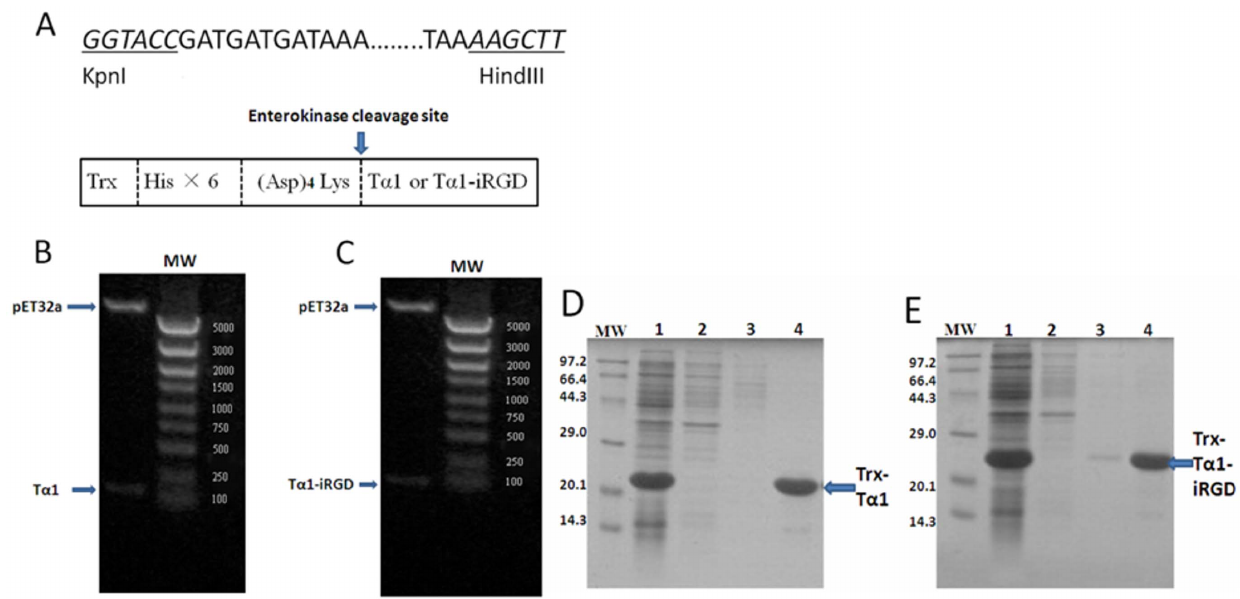
Figure 1. Production of T a 1 and T a 1-iRGD peptides. A. Restriction sites are indicated in underline, the translated amino acid and Trx-His 6 6- (Asp) 4 Lys- tag are shown in the box. B. and C., pET32a/T a 1 and pET32a/T a 1-iRGD clones digested with KpnI and HindIII and analyzed by gel electrophoresis analysis (1.2%). MW=molecular weight markers, bp; D. and E. Trx-T a 1 and Trx-T a 1-iRGD purified from BL21 (DE3) lysate, Lane 1, Trx- T a 1 or Trx-T a 1-iRGD induced by lactose in E. coli BL21 (DE3); Lanes 2 and 3, nonbinding protein of crude extract that were subjected to nickel- chelating affinity resin; Lane 4, purified Trx-T a 1 or Trx-T a